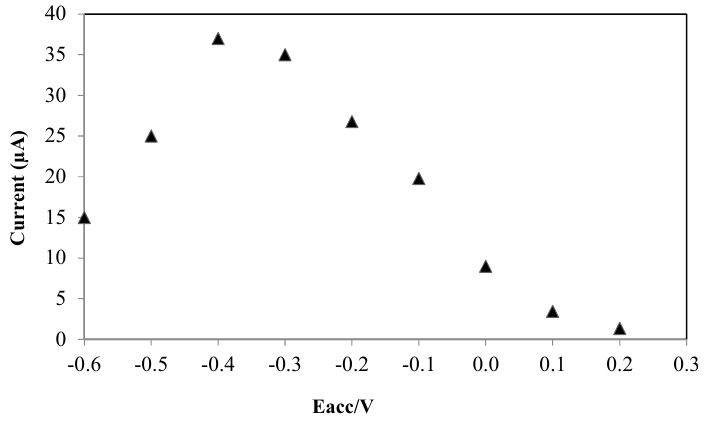
Figure 5. Effect of accumulation potential on the oxidation peak current of Amoxicillin on the surface of AuNPs/en-MWCNTs/SPE. Amoxicillin, 10 µ M; Phosphate buffer, pH 7.0; Accumulation time, 60 s.